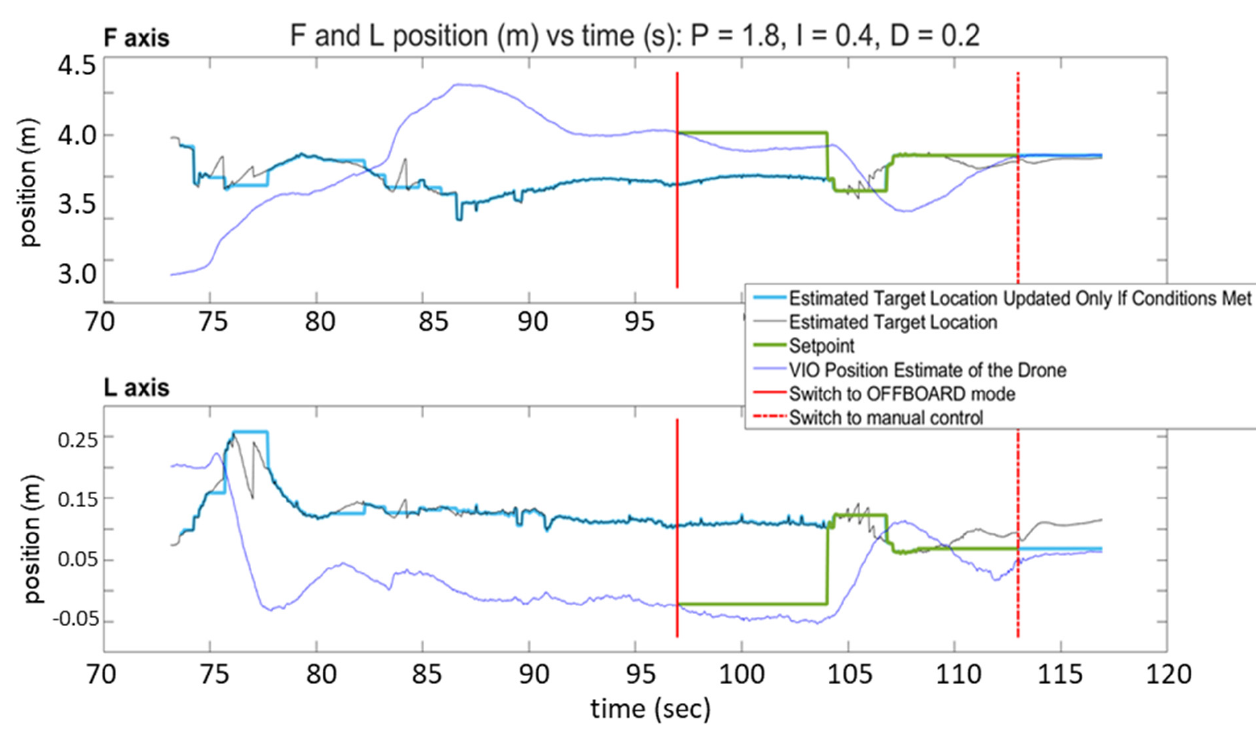
Figure 15. ArUCo automated landing experiment: position vs. time for F and L axes.